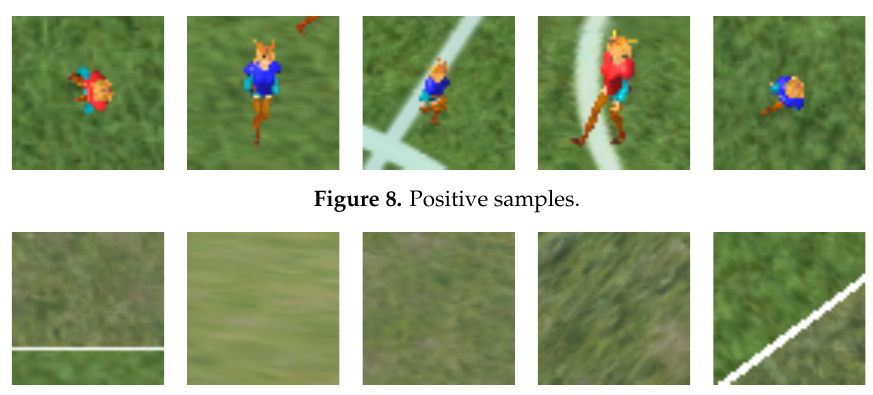
Figure 9. Negative